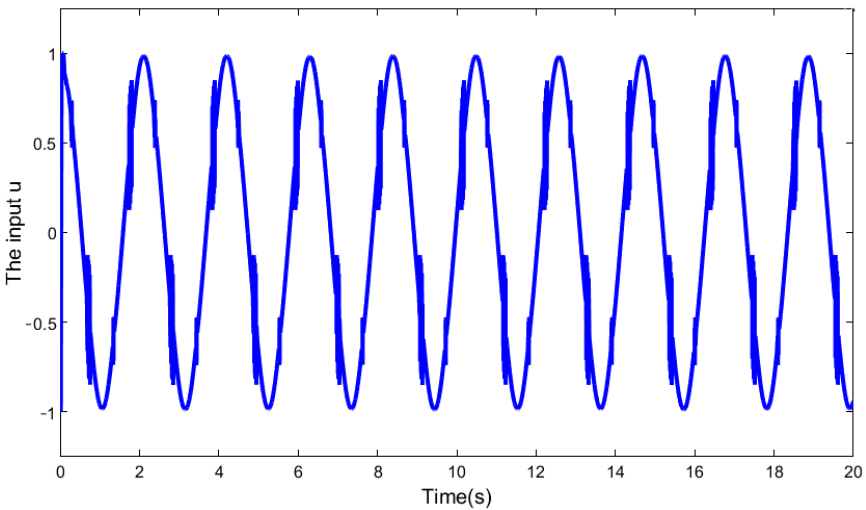
Figure 17. Control input for GSTDO-GSTBSMC u in Experiment 3.